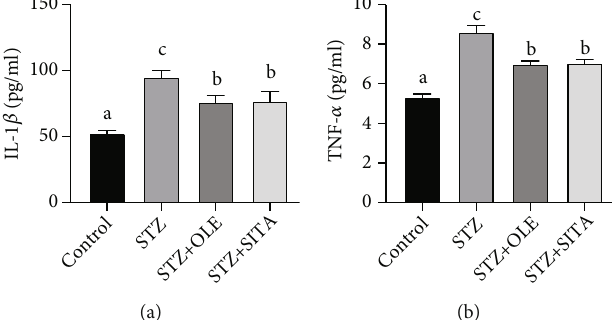
Figure 4: The e ff ect of oleuropein on neuroin fl ammation in diabetic rats. ELISA analysis of in fl ammatory factors including IL-1 β (a), and TNF- α (b) in the hippocampus tissue of the rats. Each set contains data from 3 samples tested independently; LSD test was used for multiple comparisons. ∗∗ p < 0 : 05 vs. control group and ## p < 0 : 05 vs. STZ group.